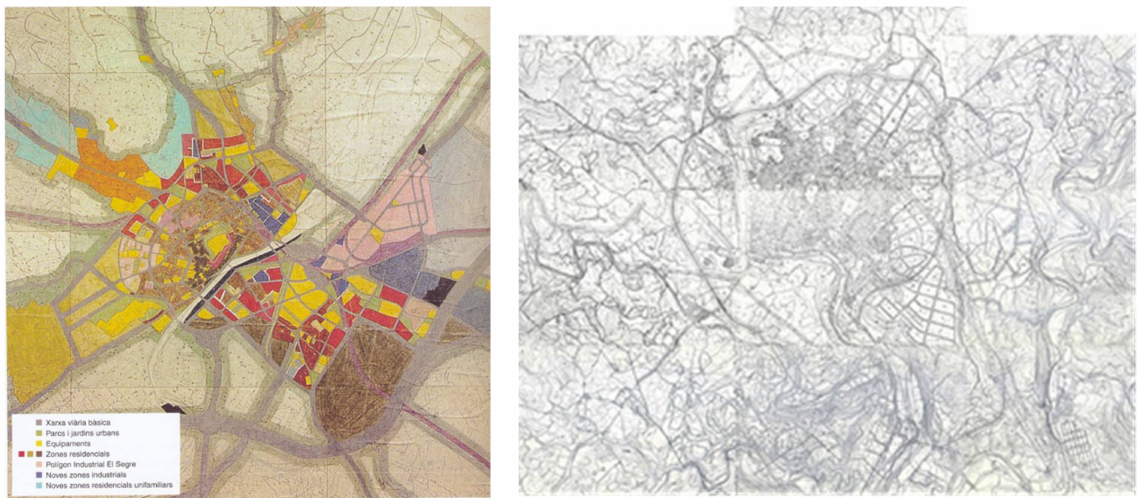
Figure 3. Plan General Municipal de Lleida of 1979 ( left ), reprinted with permission from ref. [41] and Plan General Municipal de Manresa of 1981 ( right ), reprinted with permission from ref.